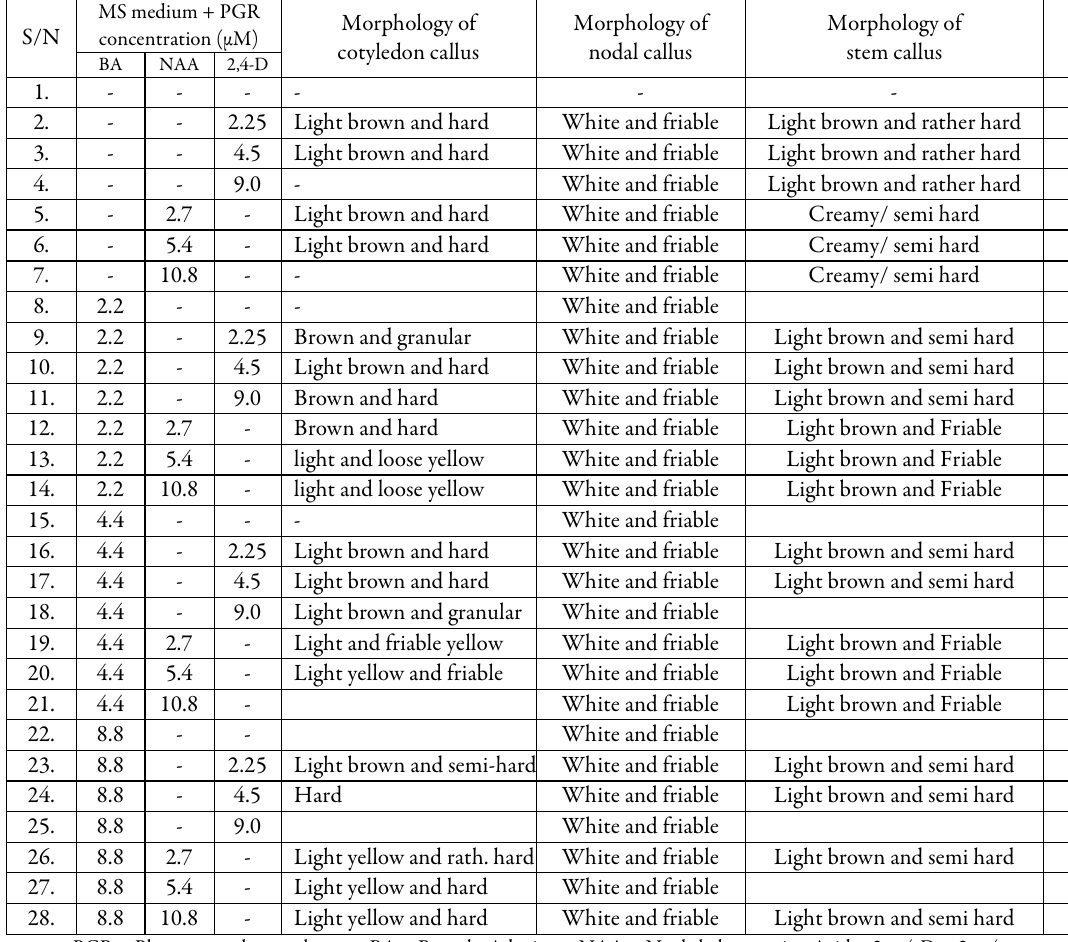
Table 5. The effects of various concentrations of NAA, 2, 4-D alone or each separately combined with BA on morphology of callus from stem, cotyledon and nodal explants of E.